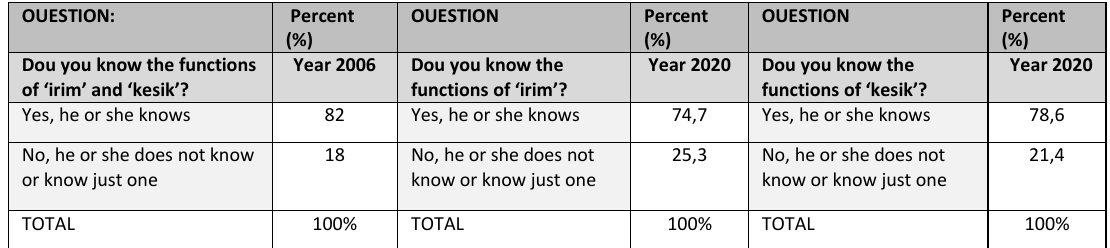
OUESTION Percent (%)